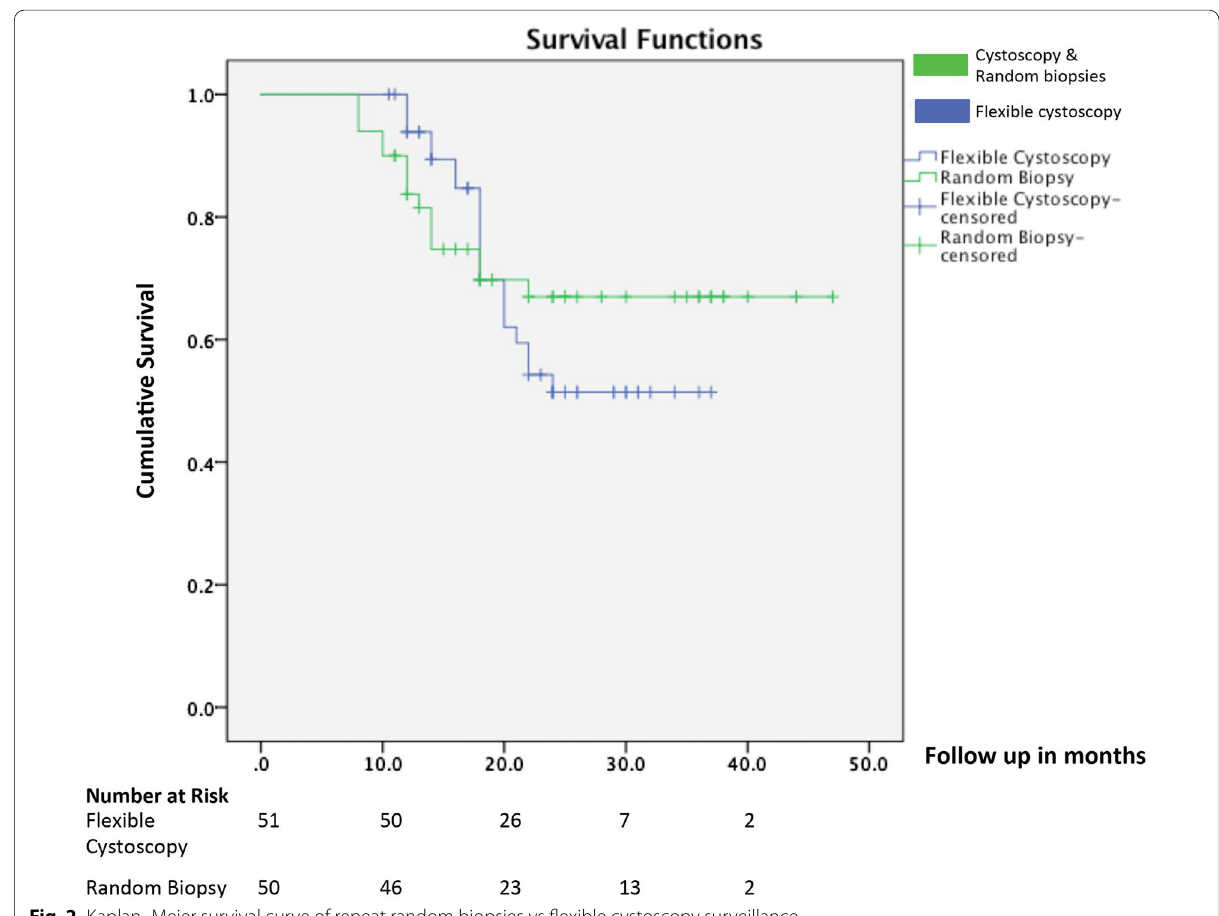
Fig. 2 Kaplan–Meier survival curve of repeat random biopsies vs flexible cystoscopy surveillance Table 2 Predictors of recurrence and time to recurrence in patients with non‑invasive muscle bladder